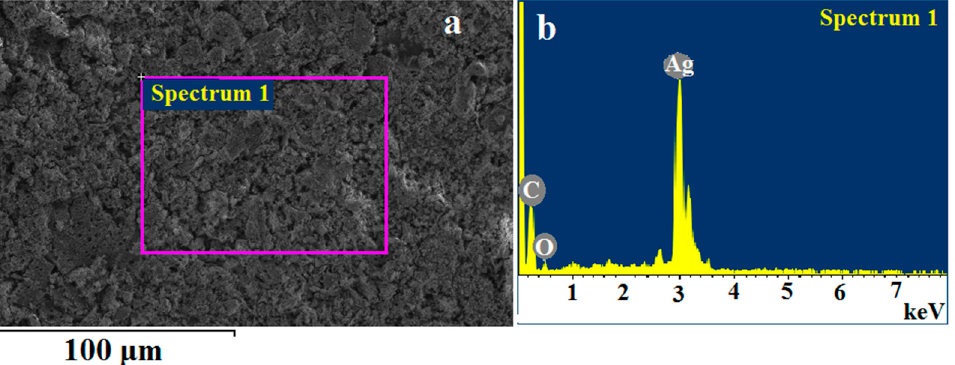
Figure 7. Energy dispersive analysis data for the thermolysis product of silver maleate. ( a ) spectrum removal area, ( b ) EDX spectrum.